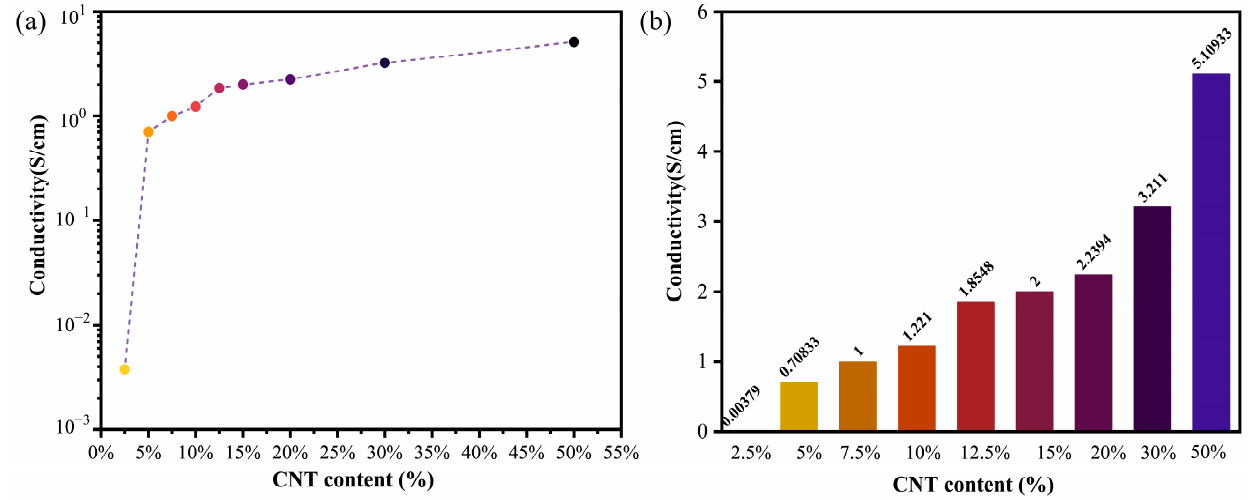
Figure 8. Comparative conductivity of CNTs/OCWPU with different CNTs content: ( a ) dotted line plot, ( b ) histogram.